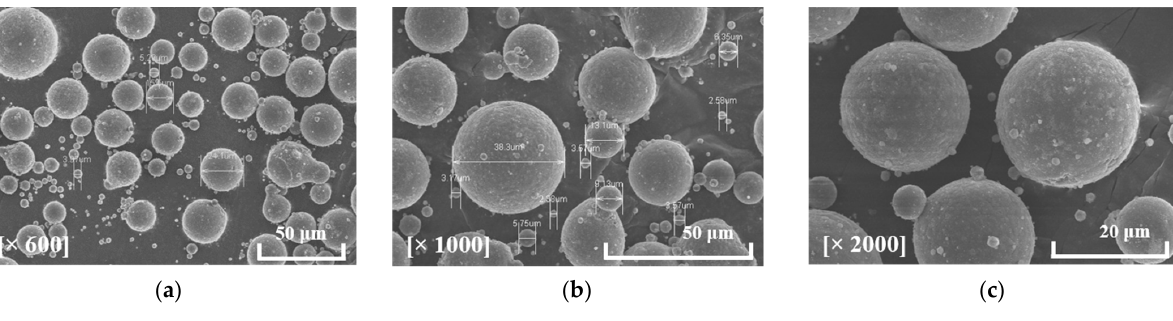
Figure 16. SEM images of AlSi7Mg metal powder in various magnifications: ( a ) 600×; ( b ) 1000×; ( c ) 2000×. ( c ) 2000 × . Table 1. Thermal and physical properties of AlSi7Mg. Table 1. Thermal and physical properties of AlSi7Mg.